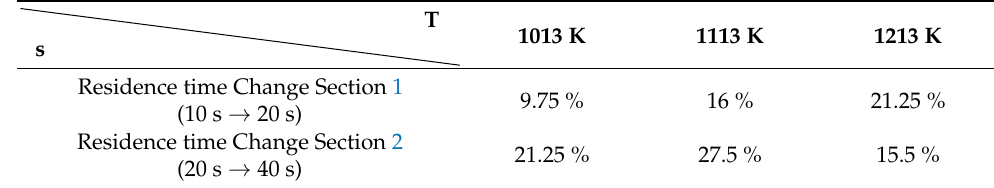
Table 4. Reduction rate of N 2 O depending on change in residence time and reactor temperature.